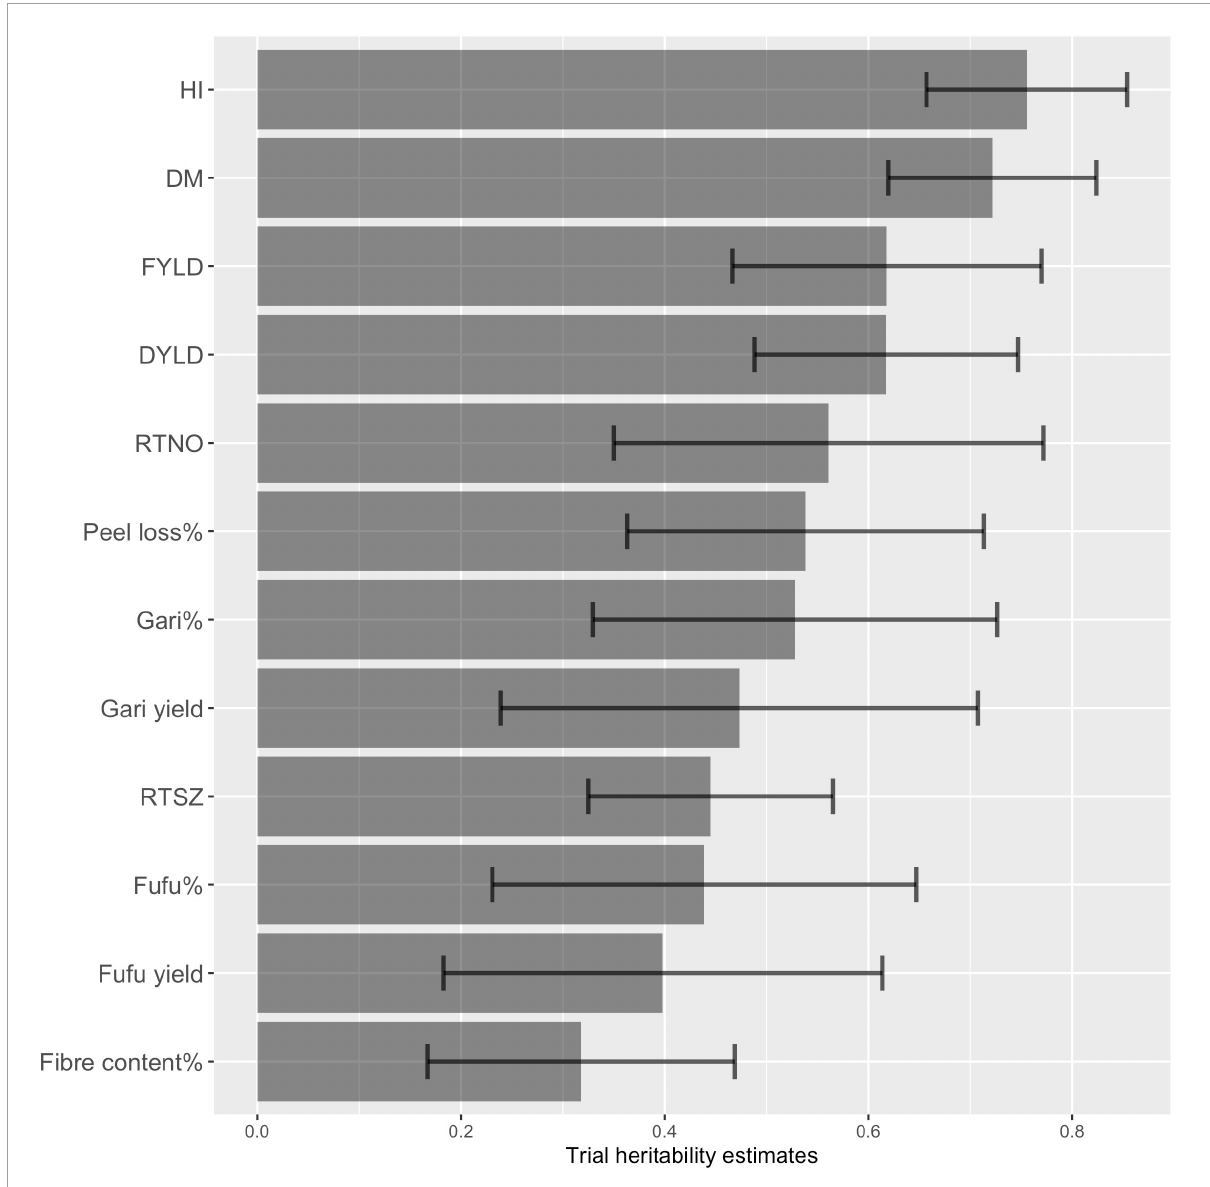
FIGURE4 Broad-sense heritability estimated for 12 processed product and yield traits based on H2_Cullis method with error bars (standard deviation). DM, Drymatter, RTNO, Root number, DYLD, Dry root yield; FYLD, Fresh root yield; HI, Harvest index; RTSZ, Root size.